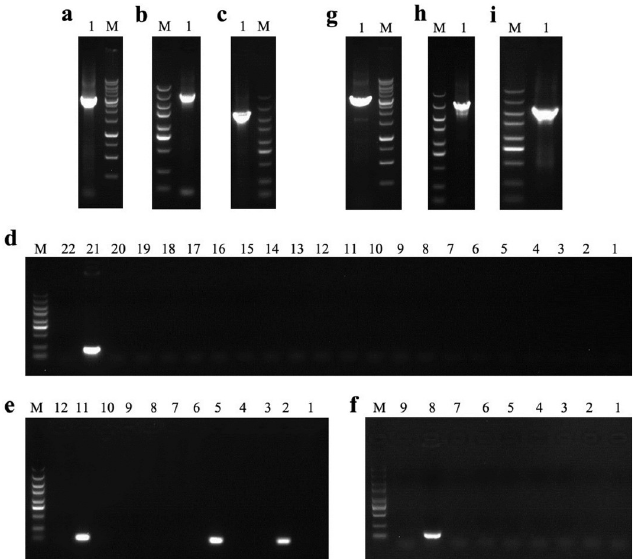
Fig 1. Agarose gel electrophoresis results of PCR products. Lane M: DNA molecular weight standard. (a) The fusion PCR result from the upstream and downstream homologous recombinant arms of crc and a kanamycin-resistant gene. Lane 1: Targeting sequences with a length of 3232 bp, containing upstream homologous recombination arm (918bp)– coding sequence of kanamycin resistant gene- downstream homologous recombination arm (847bp). (b) The fusion PCR from the upstream and downstream homologous recombinant arms of crcY and kanamycin-resistant gene. Lane 1: Targeting sequence with a length of 3167 bp, containing upstream homologous recombination arm (809bp) -coding sequence of kanamycin resistant gene-downstream homologous recombination arm (891bp). (c) The fusion PCR from upstream and downstream homologous recombination arms of crcZ and gentamicin-resistance gene. Lane 1: Targeting sequence with a length of 2611 bp, containing upstream homologous recombination arm (776bp) -coding sequence of gentamicin resistant gene-downstream homologous recombination arm (946bp). d-e: PCR products with internal identified primers in CCR gene knockout strains. (d) PCR of crc knockout strain. Lane 1–20: The amplification results of colonies No.1-20. If crc was knockout, no product could be detected; Lane 21: The amplification result of the original strain, and the length of product was 223 bp; Lane 22: The amplification result of negative control, and no product was amplified. (e) PCR of crcY knockout strain. Lane 1–10: The amplification products of colonies No. 1–10. If crcY was knockout, no product could be detected; Lane 11: The amplification results of the original strain, and the length of the product was 146 bp; Lane 12: The amplification result of negative control, and no product was amplified. (f) The PCR identification result of crcZ knockout strain. Lane 1–7: The amplification results of colonies No. 1–7. If crcZ was knockout, no product could be detected; Lane 8: The amplification results of the original strain, and the length of the product was 149 bp; Lane 9: The amplification results of negative control, and no product was amplified. g-h: PCR products using external identified primers in CCR gene knockout strains. (g) PCR identification result of crc knockout strain. Lane 1: The amplification result of No.1 colony. (h) The PCR product of the crcY knockout strain. Lane 1: The amplification result of No.1 colony. (i) The PCR identification result of crcZ knockout strain. Lane 1: The amplification result of No.1